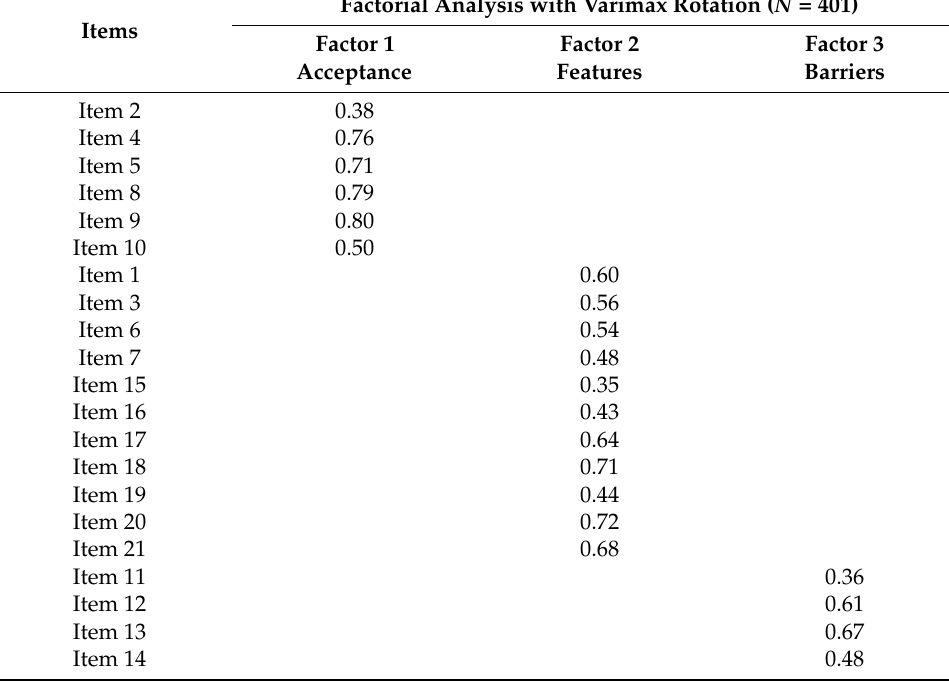
Table 8. Rotated components